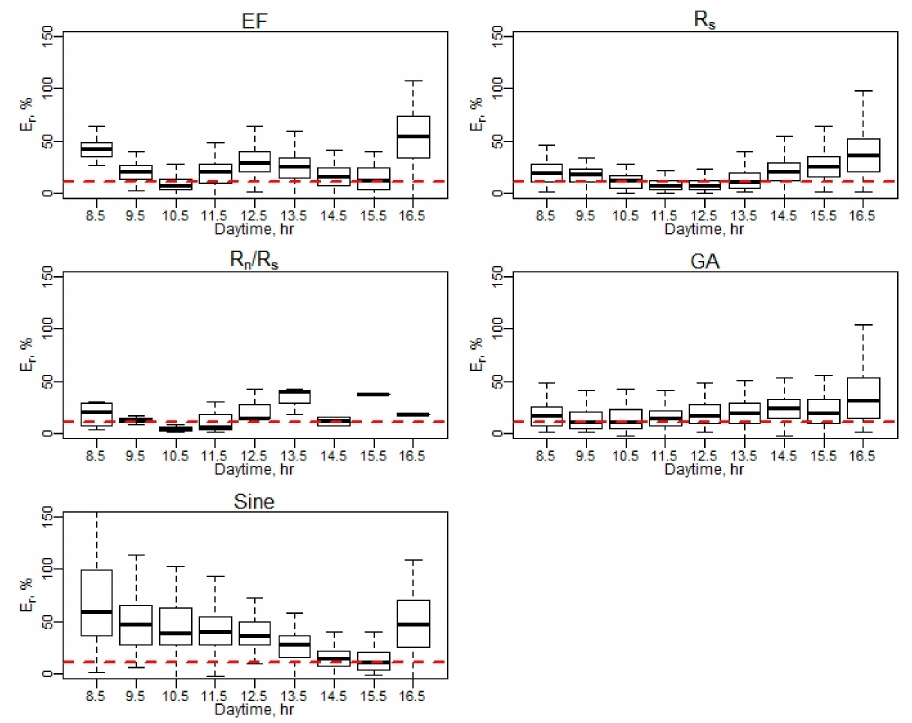
Figure A10. E r of daily EC ET (September–October). Note: Red dash line represents a 10% relative error ( E r